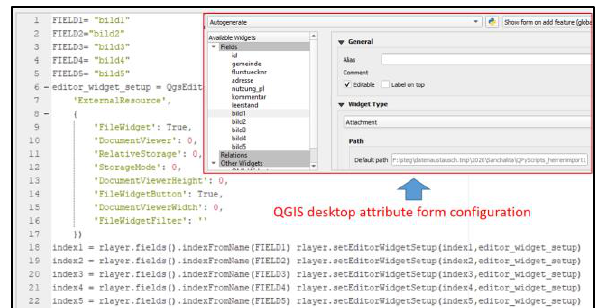
Figure 4 : Python script for attribute form configuration for widget type “attachment”.